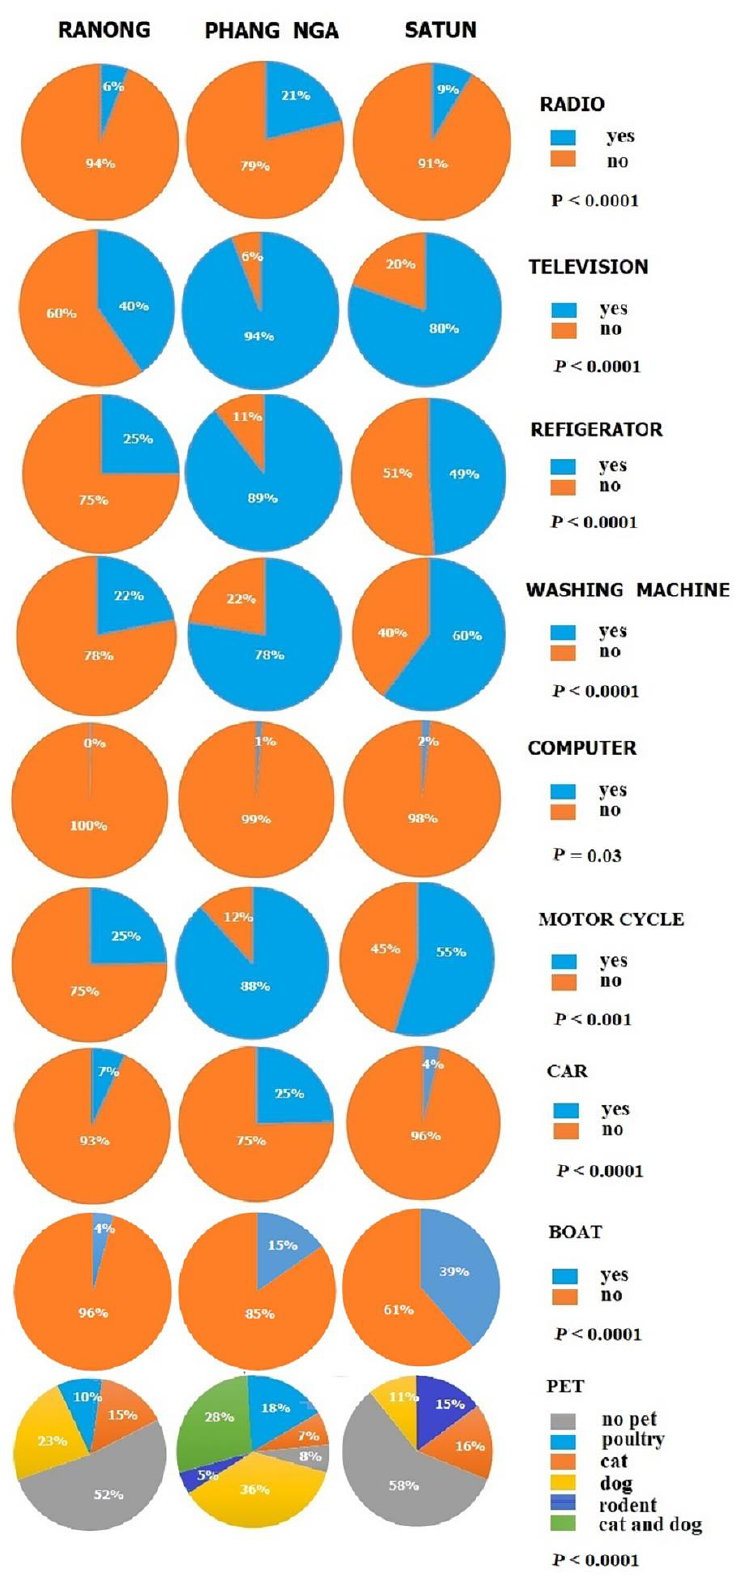
Figure 5. Pie graphs showing data on the sanitary conditions of the study population, i.e., the Moken from Ranong, the Moken from Phang Nga, and the Orang Laut from Satun